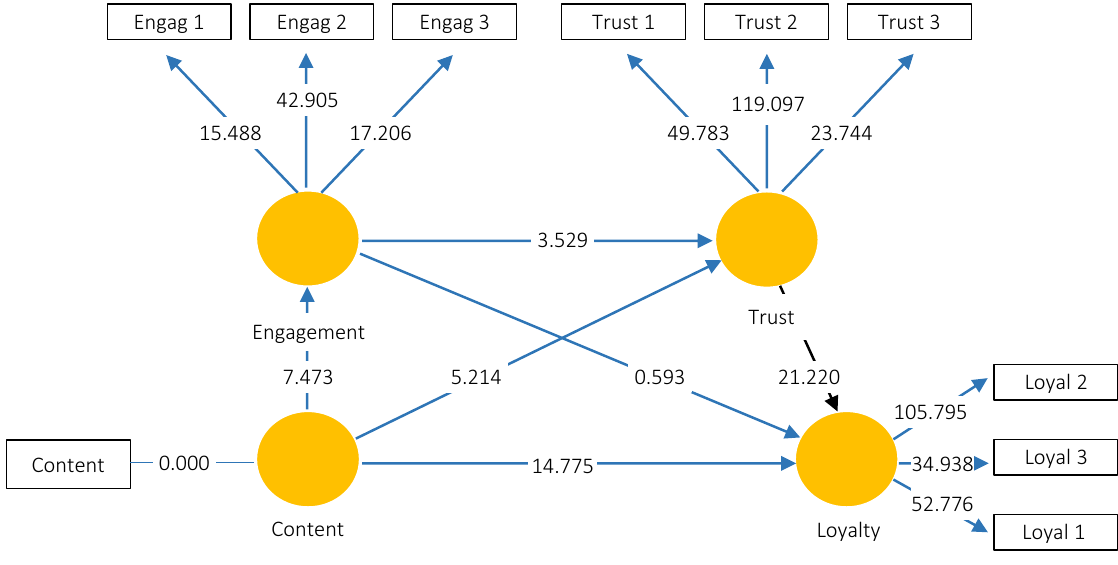
Figure 3. PLS model bootstrapping